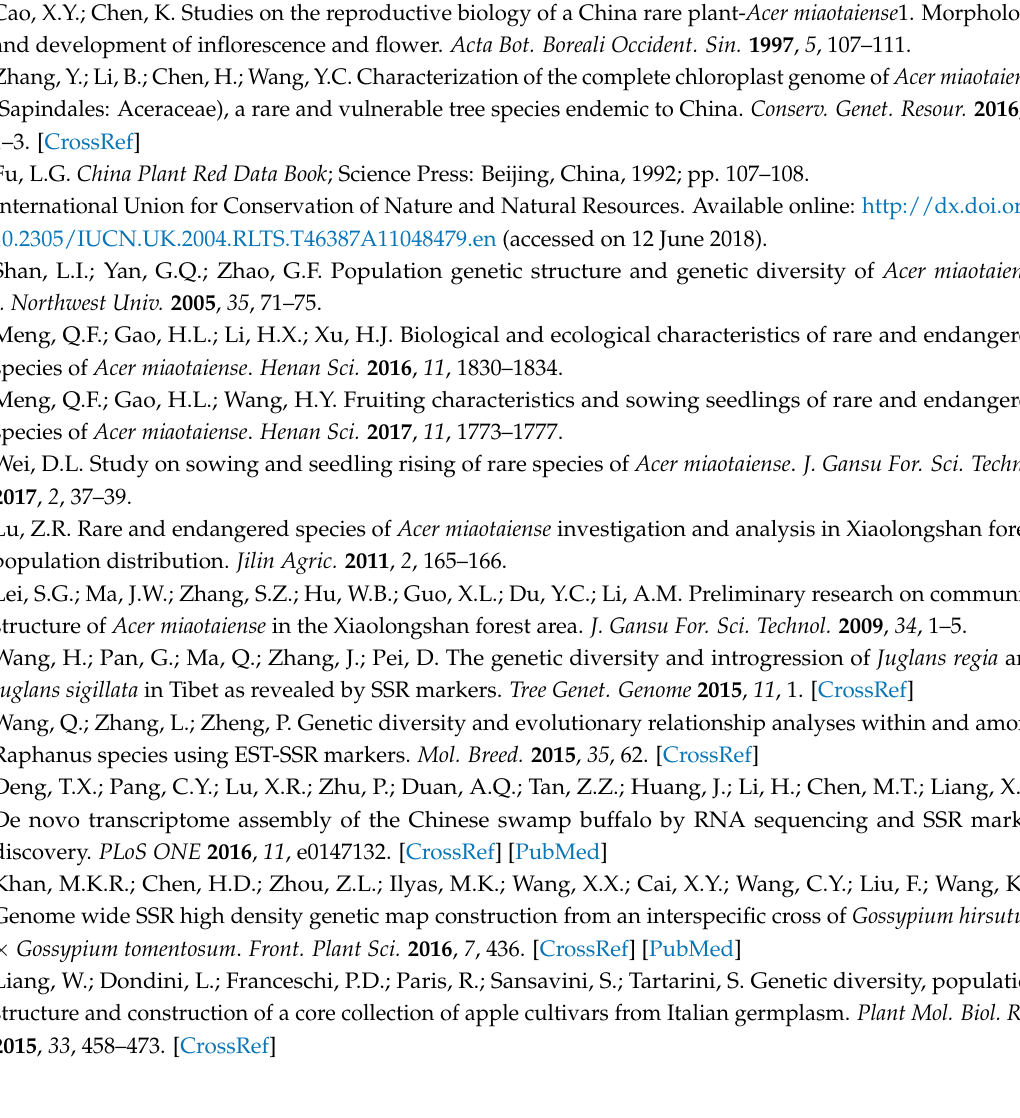
Figure S1: Eukaryotic orthologous groups (KOG) classification of Acer miaotaiense unigenes, Figure S2: Distribution of the top BLASTX hits for the unigenes in the NCBI non-redundant protein (Nr) database, Figure S3: RMA regression of genetic distance and geographic distance (Km) matrix of Acer miaotaiense ( r 2 = 0.35, p = 0.50), Table S1: Table S4: Summary of the Analyses of EST-SSRs for A. miaotaiense , Table S5: The number of repeats in each different motif length in the Acer miaotaiense , Table S6: Frequencies of different repeat motifs in SSRs in Acer miaotaiense , Table S7: The list of 96 SSRs with stable amplification, Table S8: The gene flow value among the six populations in Acer miaotaiense